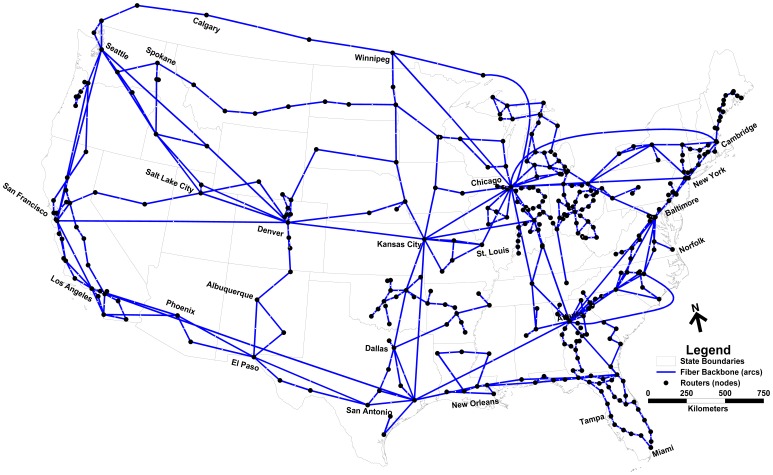
Internet2 backbone.